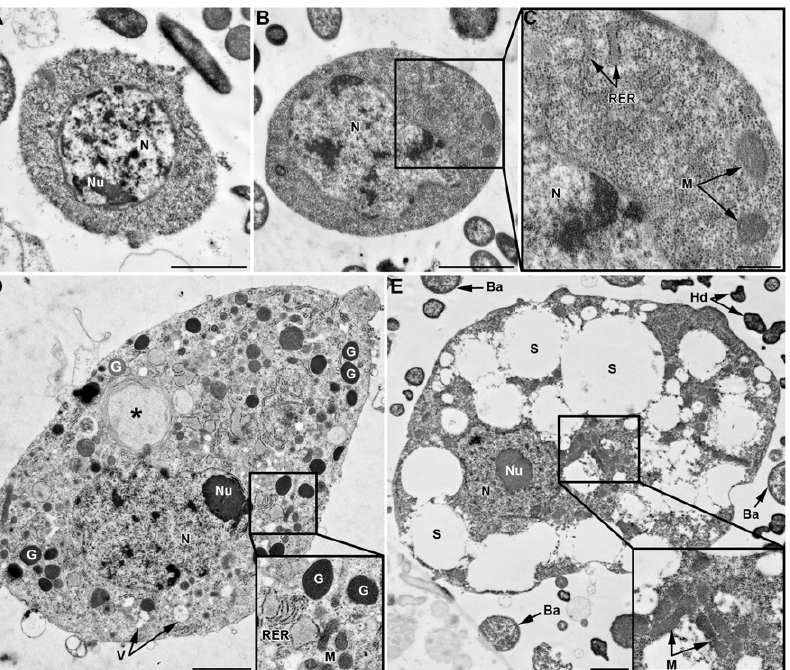
Figure 2. TEM characterization of hemocytes. Cells from the LL01 clone (A–D) and the YR2-Hd line (E). (A) Prohemocyte characterized by a round nucleus ( N ), a high N/C ratio, and homogenous cytoplasm devoid of apparent organelles. (B) Plasmatocyte with homogeneous cytoplasm, a lobulated nucleus, a high N/C ratio and some cytoplasmic organelles clearly visible in box (C): Rough Endoplasmic Reticulum ( RER ), Mitochondria ( M ). (D) Granulocyte with a lobulated nucleus, a low N/C ratio, and granules (G) . The cytoplasm contains numerous organelles (see box). A phagosome is observed that contains a large foreign particle (asterisk). (E) YR2-Hd spherulocyte with a round nucleus and a low N/C ratio. The large volume of cytoplasm is filled with spherules ( S ) of different sizes, and numerous mitochondria are found in a small region (enlarged box). Ba : B. aphidicola ; Hd : H. defensa . Scale bar: 2 m m (A, B, D, E) and 0.5 m m (C).